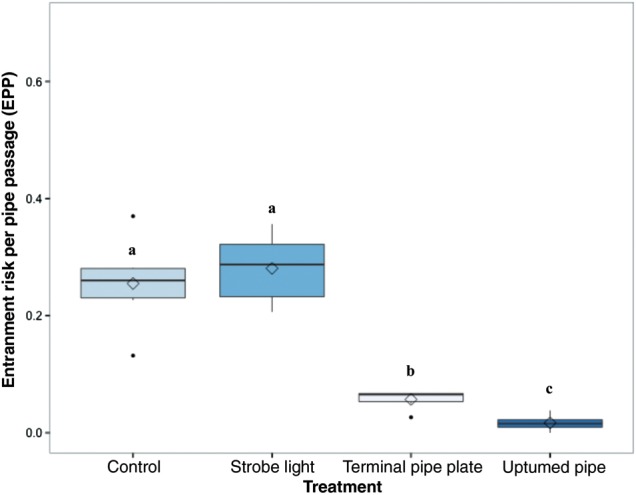
Entrainment risk per pipe passage (EPP) for each treatment. Boxplots of the risk of an individual fish becoming entrained after passing the diversion pipe a single time, moving either upstream or downstream. Different letters represent statistically significant differences among treatments. Key: black line, median; box, interquartile range; whiskers, 1.5 × interquartile range; filled circles, outliers; and open diamond, mean. Mean proportions of fish diverted for each treatment (±SEM) are reported in the text. n = 6 trials for each treatment; 60 (±3) fish per trial.